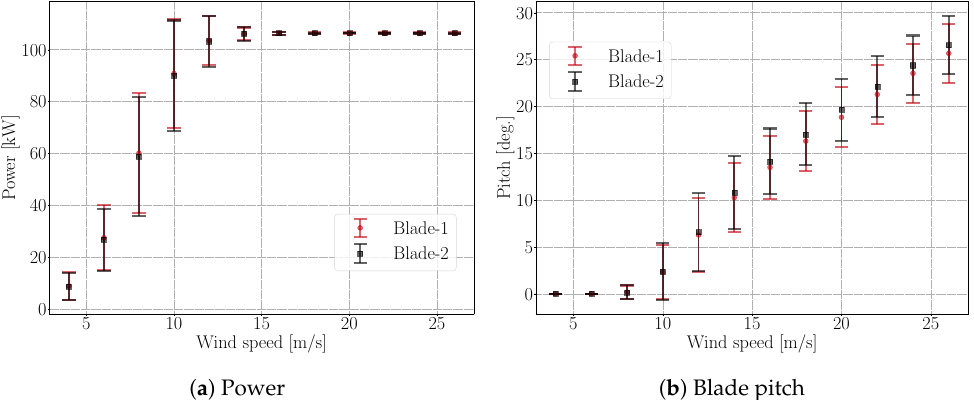
Figure 19. Mean power and pitch values and their standard deviations are shown by error bars for DLC1.2 load